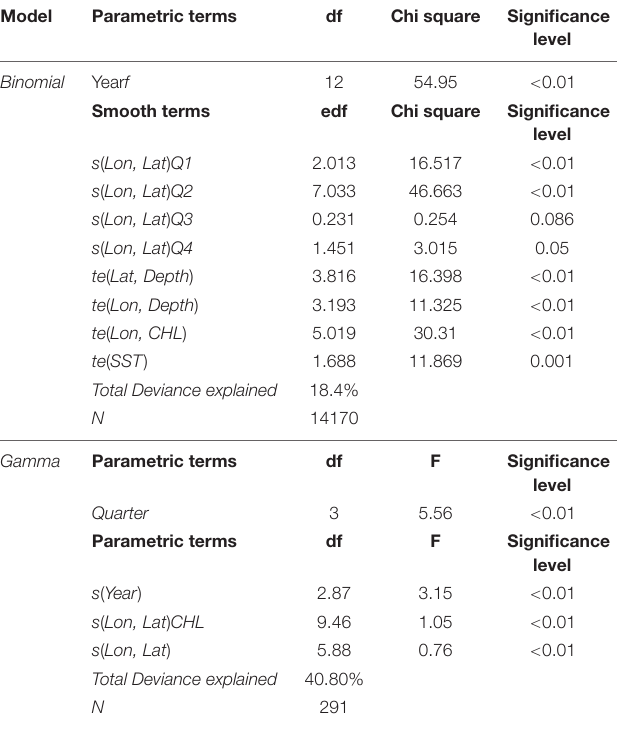
TABLE 2 | Results of generalized additive models building for factors affecting the presence/absence and the abundance of loggerhead turtles in the northern central Adriatic Sea between 2006 and